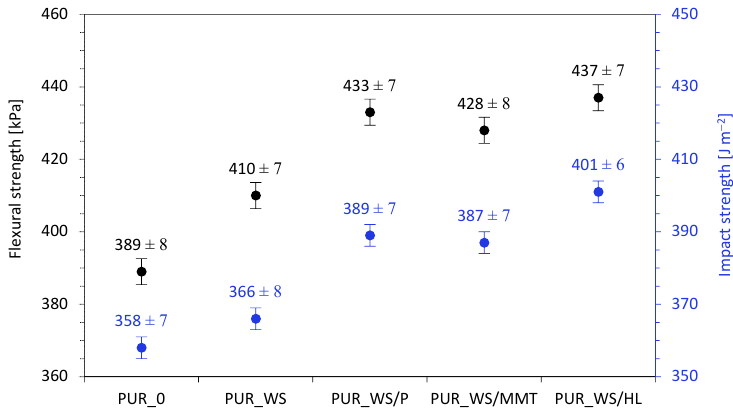
Figure 9. The impact of walnut shell fillers on the flexural strength and impact strength of PUR foams.